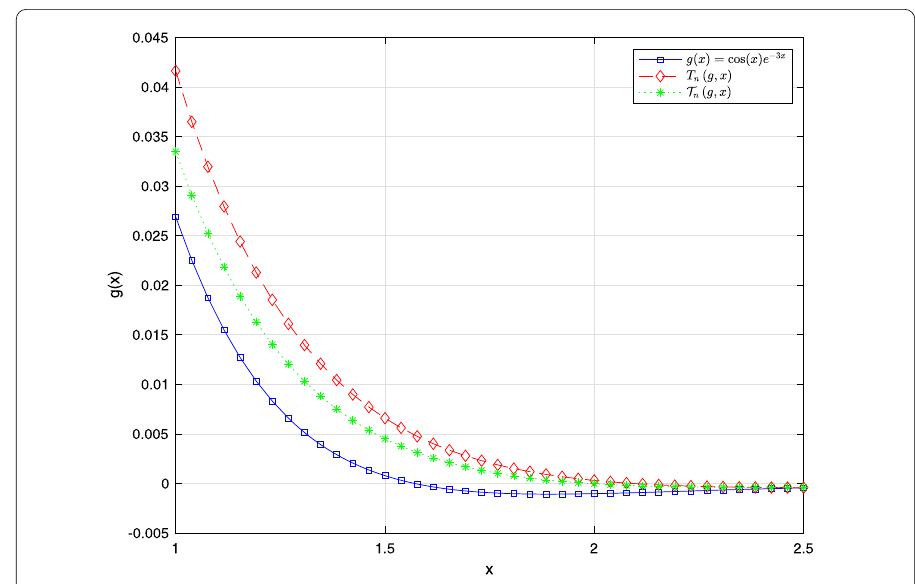
Figure 2 T n ( g , x ) and T n ( g , x ) approximation of test function g ( x ) = cos( x ) e –3 x on an equally spaced evaluation grid of [1,2.5] with n =